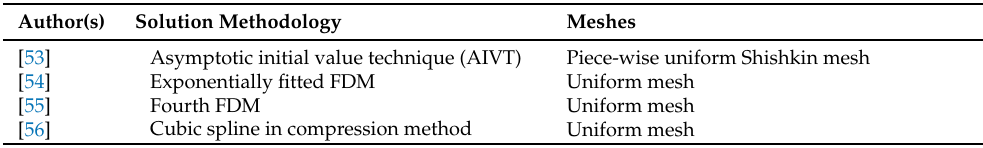
Table 4. Various methods and mesh used to solve Equations (3) and